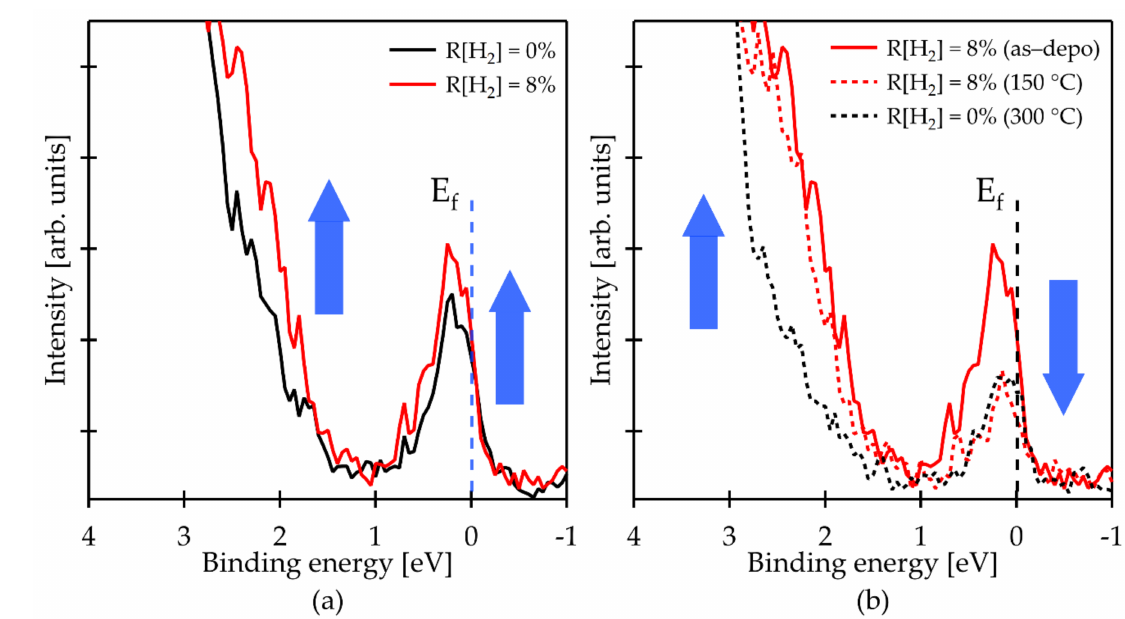
Figure 4. HAXPES spectra around band gap of the IGZO films deposited at different R[H 2 ] and at fixed R[O 2 ] = 1%: ( a ) as-deposited; ( b ) before and after annealing for 1 h in air at different